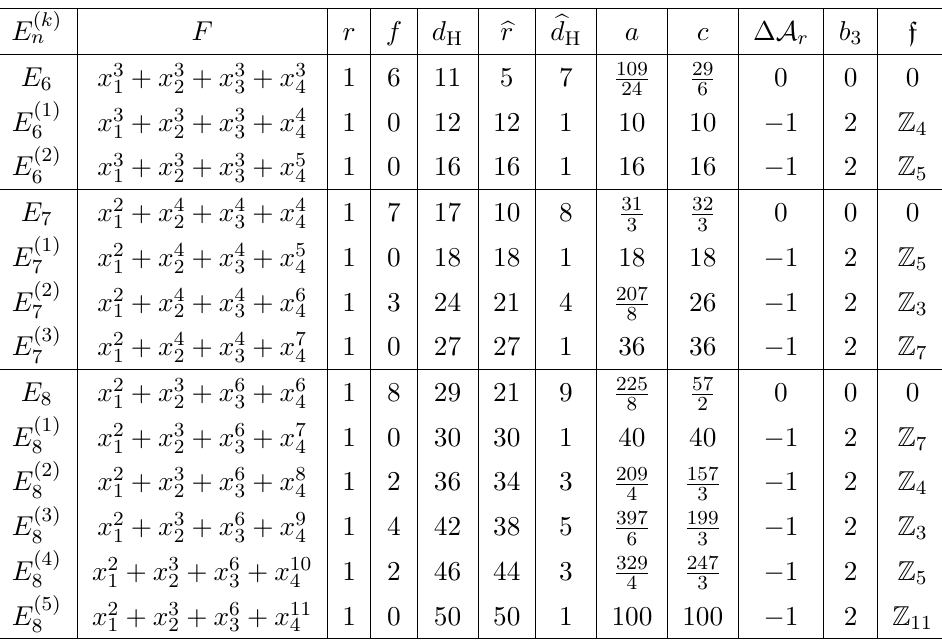
Table 3 . The r = 1 E ( k ) n